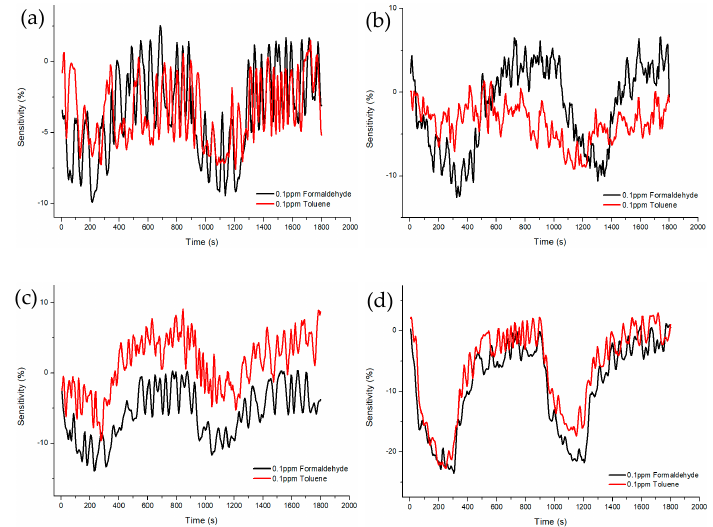
Figure 11. Sensitivity and recovery characteristics according to concentration (0.1 ppm) of formalde- hyde and toluene gas of ZnO-TiO 2 gas sensor. ( a ) ZnO(90%)-TiO 2 (10%) ( b ) ZnO(95%)-TiO 2 (5%) ( c ) ZnO(99%)-TiO 2 (1%) ( d ) ZnO(100%)-TiO 2 (0%).